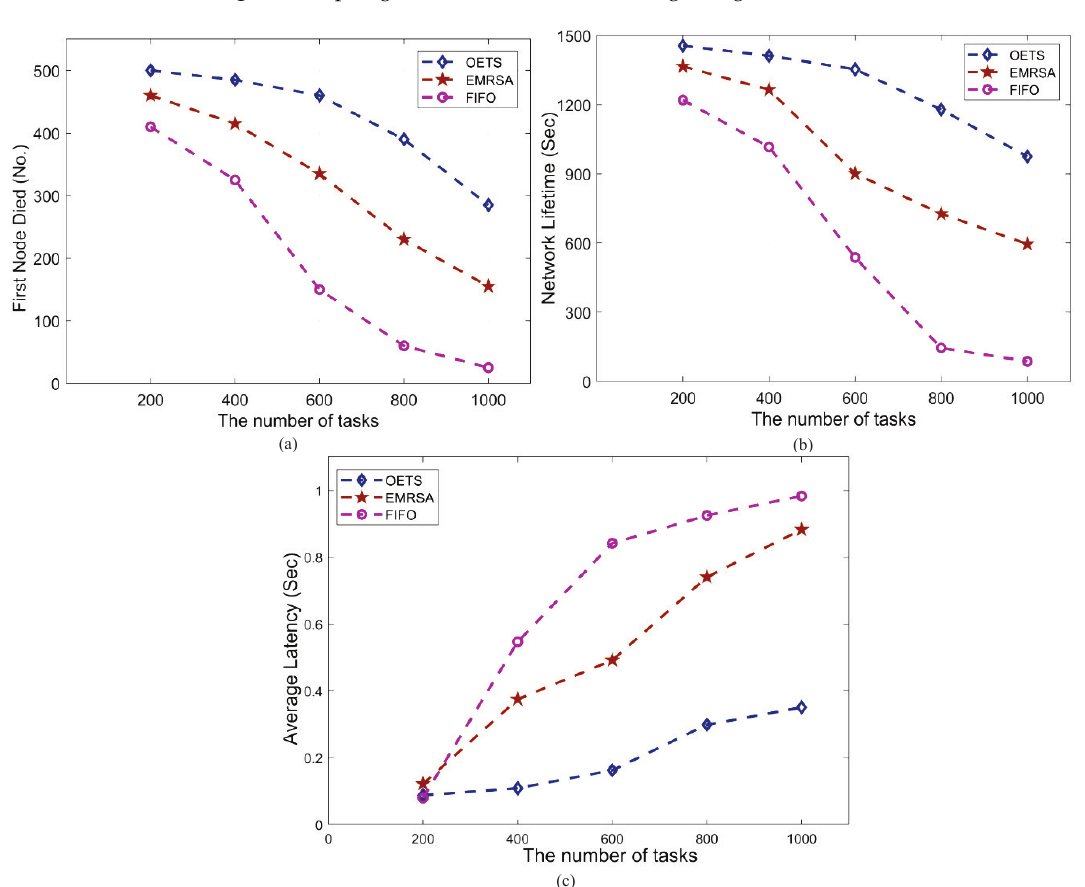
Figure 6. Simulation Results: ( a ) First Node Died, ( b ) Network Lifetime, ( c ) Average